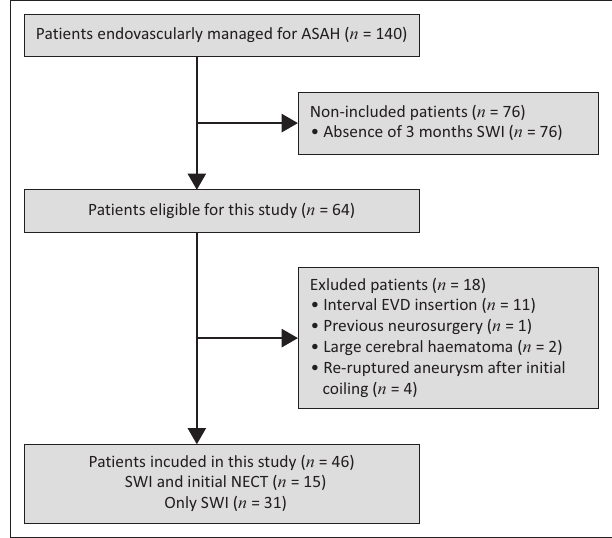
FIGURE 1: Flow chart of patient